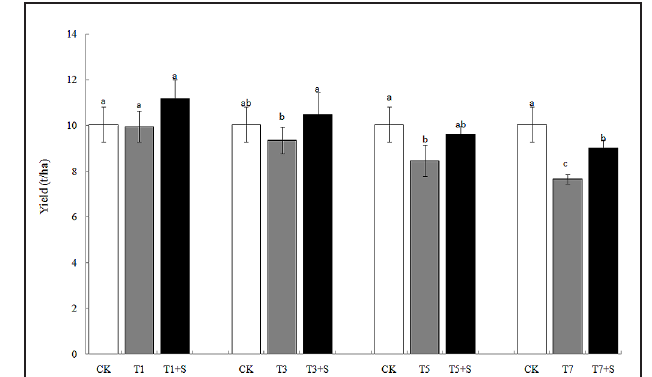
FIGURE 4 | Effects of Spd on yield of rice after